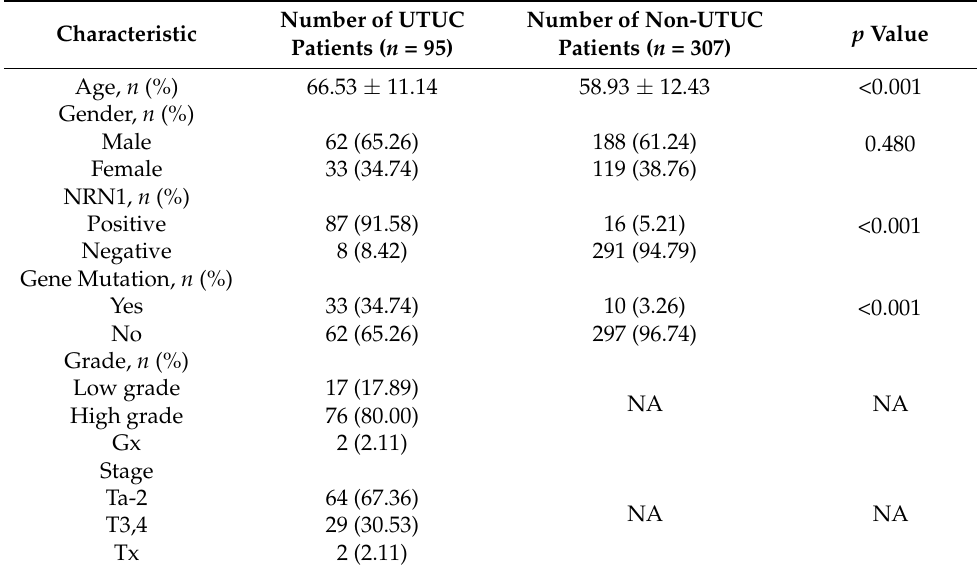
Figure 1. Sample and data processing workflow. The basic characteristics of all participants are shown in Table 1. In the UTUC+ group, 64 patients (67.36%) exhibited local disease, whereas 29 patients (30.53%) exhibited advanced disease. Furthermore, 17 patients (17.89%) had low ‐ grade disease and 76 patients (80.00%) had high ‐ grade disease. The differences in baseline characteristics (all p < 0.001) were significant between these two groups, aside from gender ( p = 0.480). The details of mutated and methylated genes are shown in Figure 2. Table 1. Clinical and histopathological characteristics of enrolled cases.